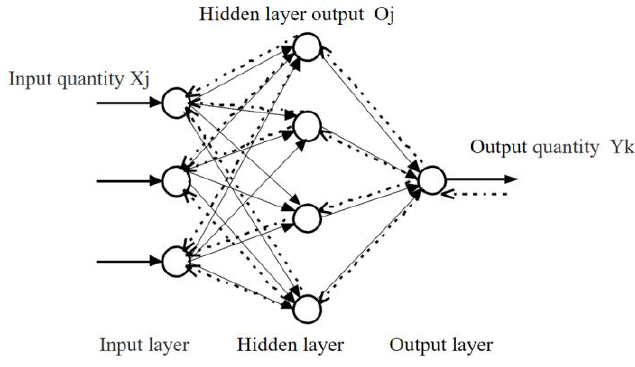
Figure 5. Single hidden layer neural network structure diagram.